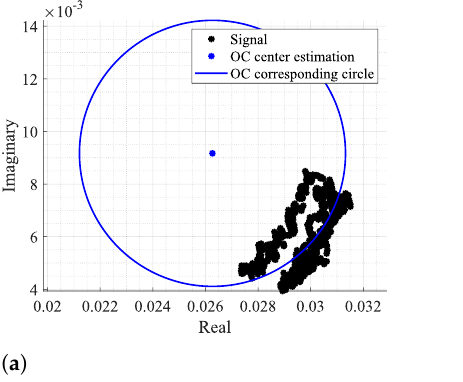
Figure 9. Center estimations in opposite arc sides in consecutive windows, using as an example: ( a ) the window nº 74, ( b ) the window nº